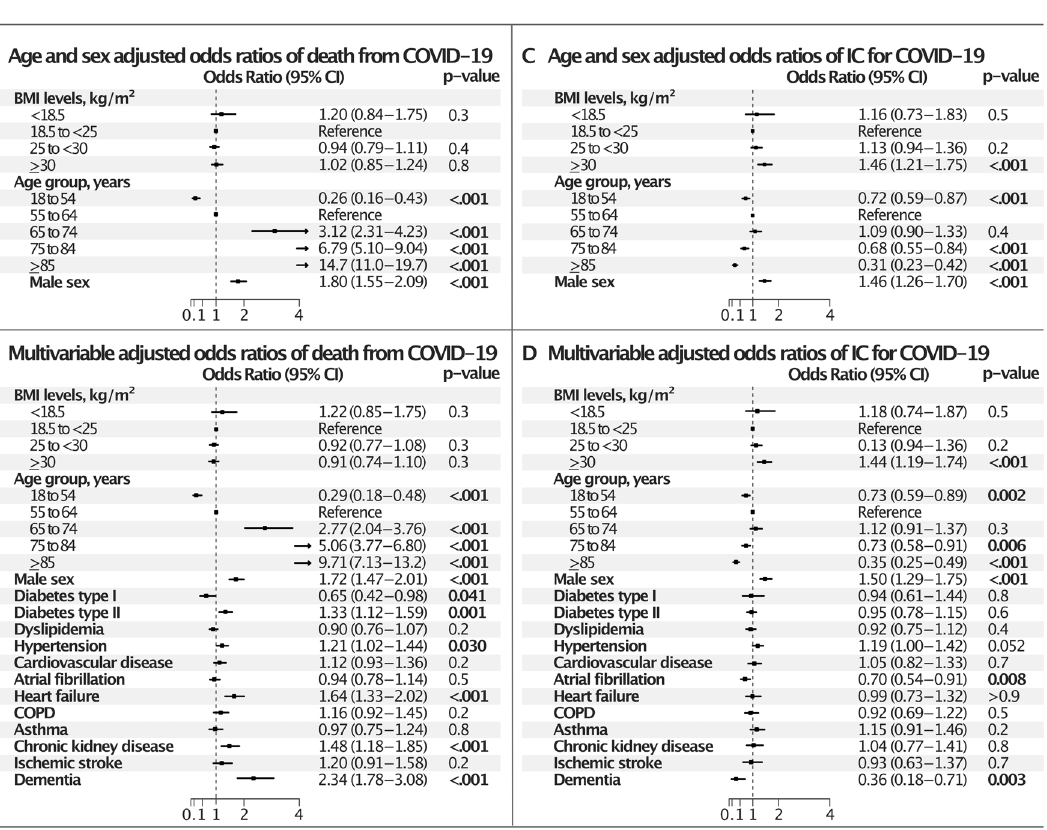
Figure 2. Age- and sex adjusted and multivariable adjusted odds ratios of IC and death from Covid 19. COPD chronic obstructive pulmonary disease, IC intensive care. (A) Age- and sex adjusted odds ratios of death, (B) multivariable adjusted odds ratios of death, (C) age- and sex adjusted odds ratios of IC, (D) multivariable adjusted odds ratios of